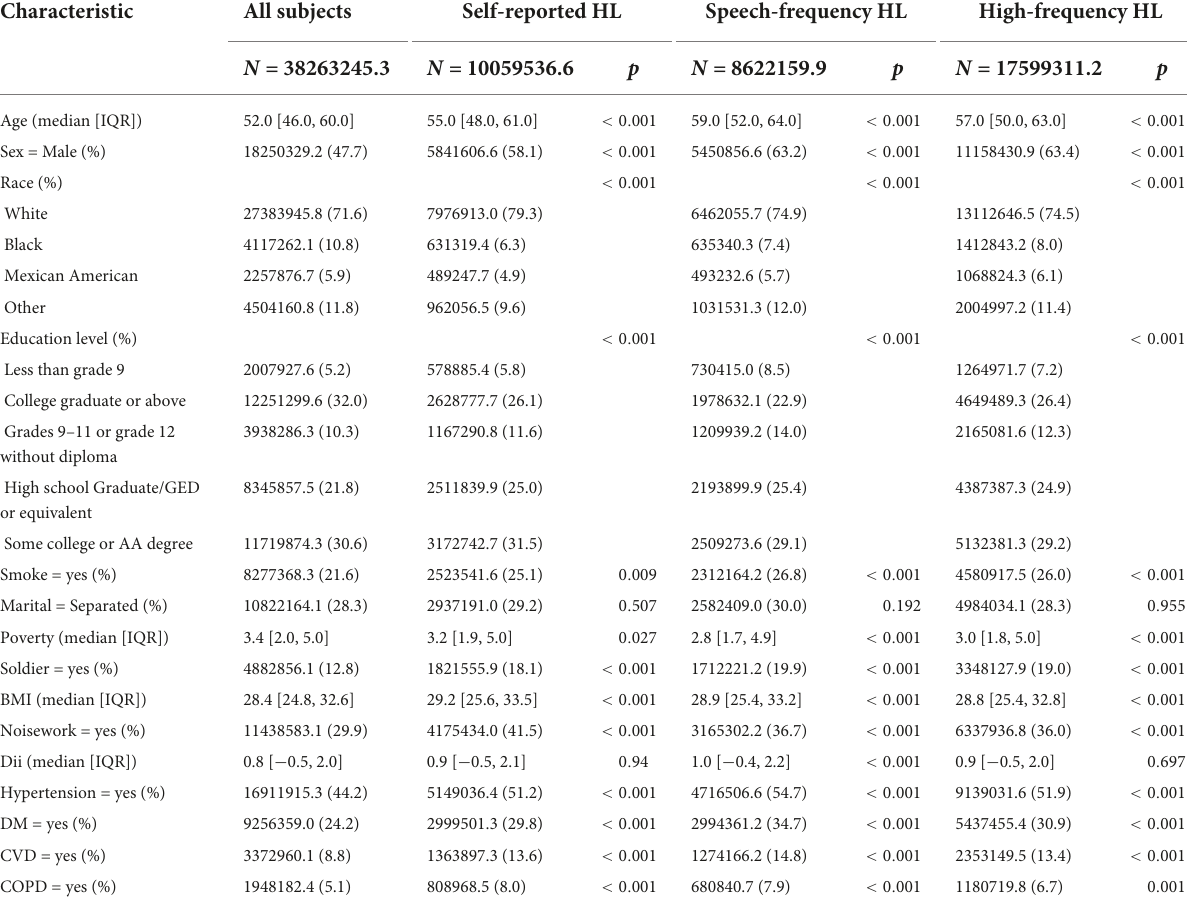
TABLE 1 The characteristics of 7,515 participants with different hearing loss (HL) subtypes in the NAHANES study.